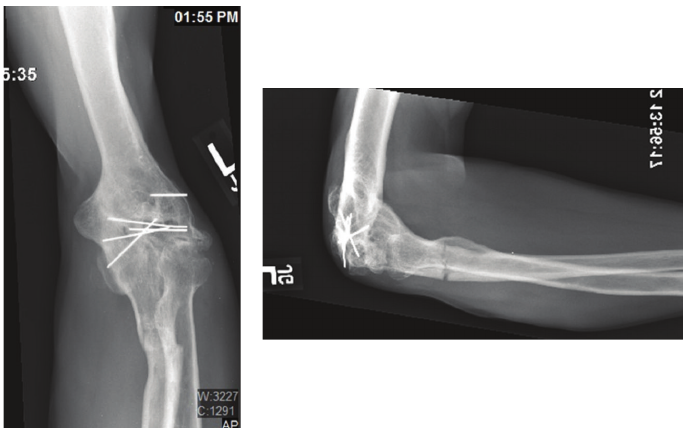
Figure 1: Plain radiographs of the elbow at the time of presentation revealed an elbow arthrodesis at 90 degrees with retained hardware and a minimally displaced transverse proximal ulnar shaft fracture.